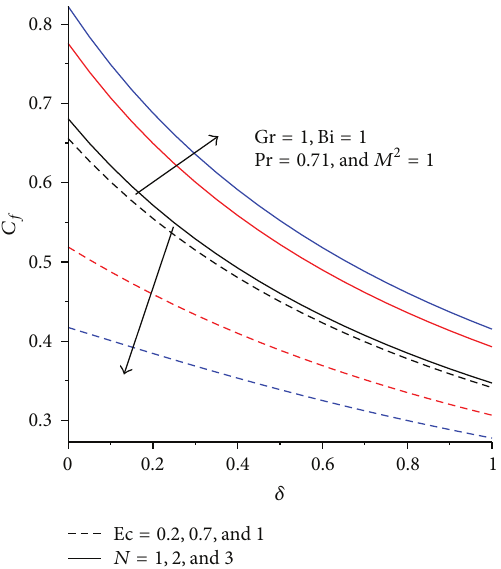
Figure 19: Skin friction with increasing Ec, 𝑁 , and 𝛿 .